Question: Which kind of chart has been used to present this data?
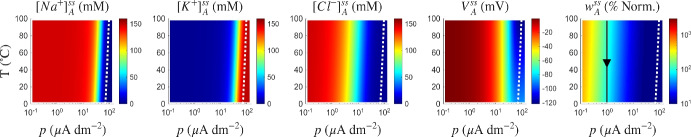
Answer: line